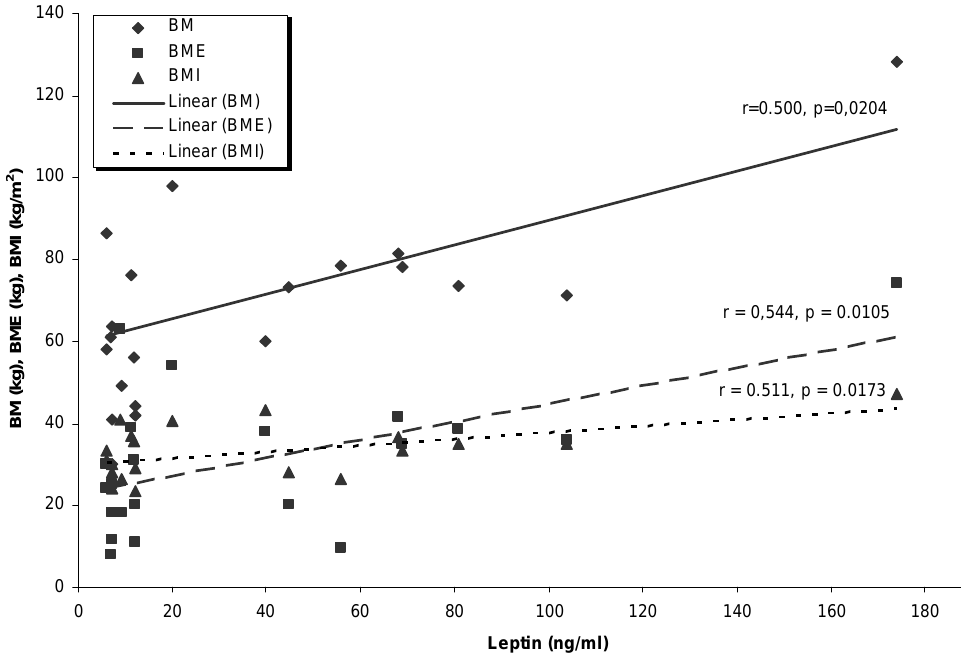
FIGURE 3 . Correlations of leptin levels with BM, BME, and